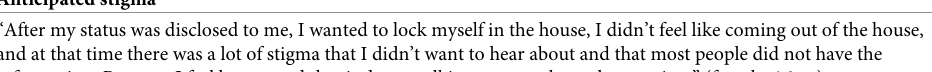
Table 2. Post-disclosure negative feelings among adolescents with delayed disclosure (illustrative notes). Anticipated